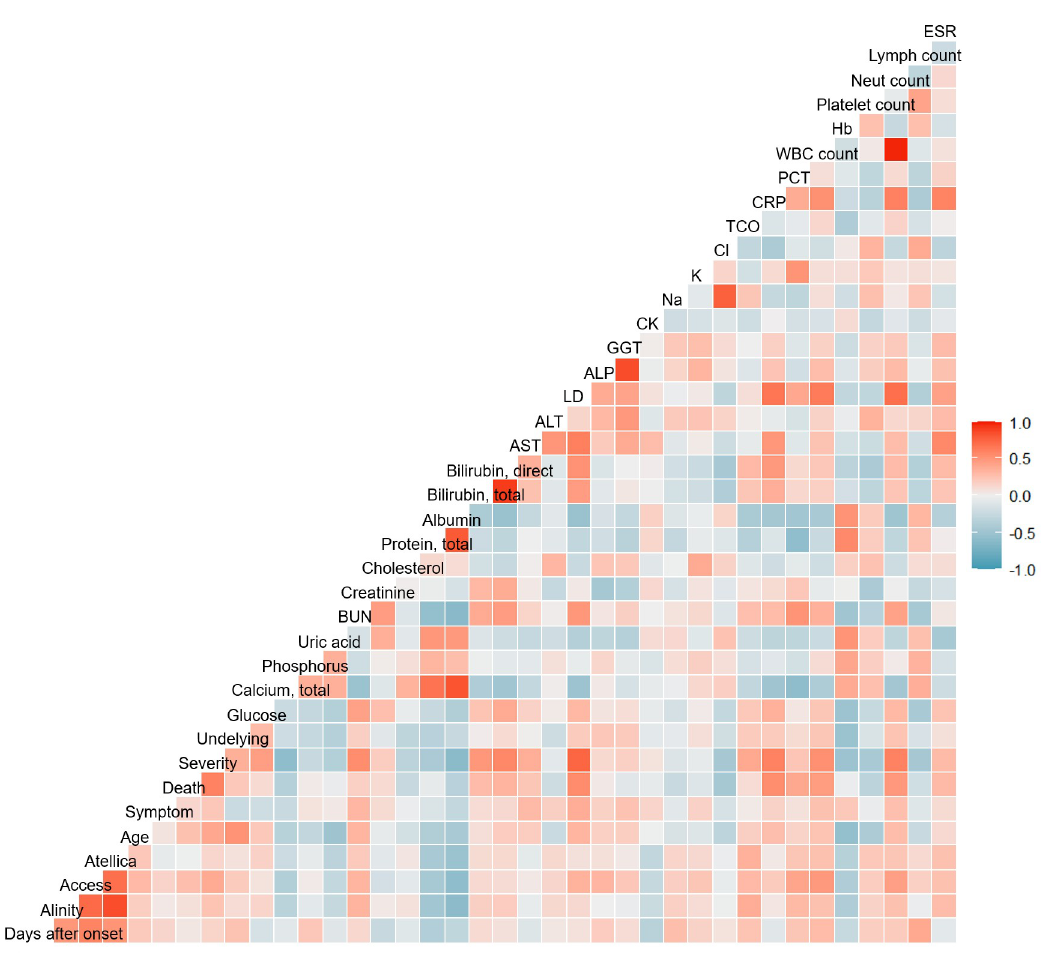
Fig 5. Pairwise association between clinical biomarkers indicating disease severity and SARS-CoV-2 antibody index.